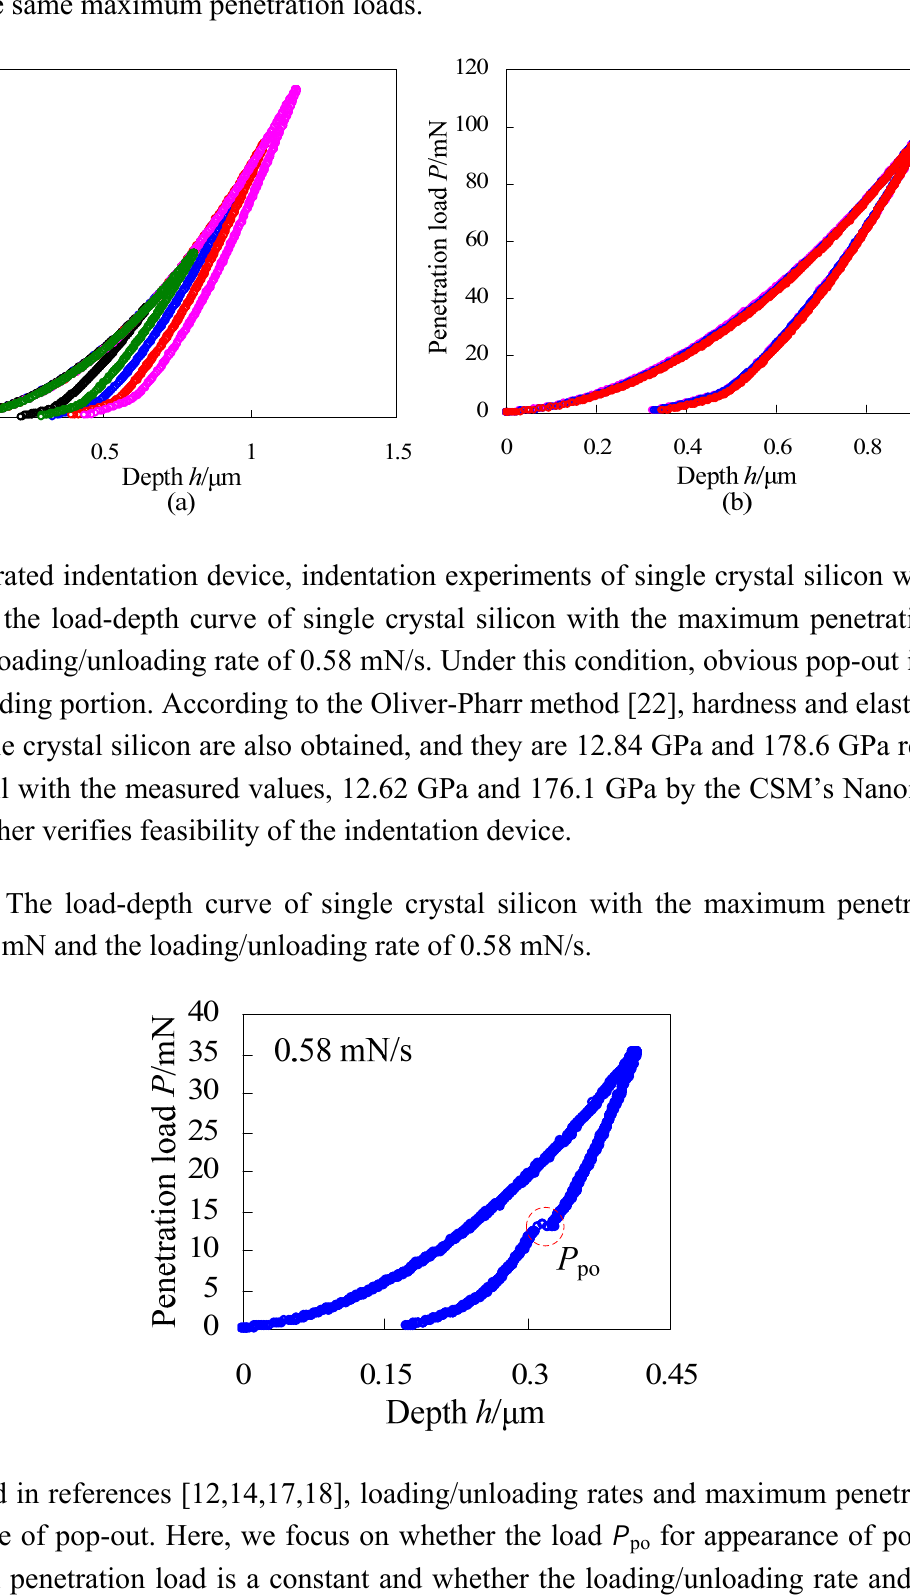
Figure 2. Repeatability tests on fused quartz with ( a ) different maximum penetration loads and ( b ) the same maximum penetration loads.